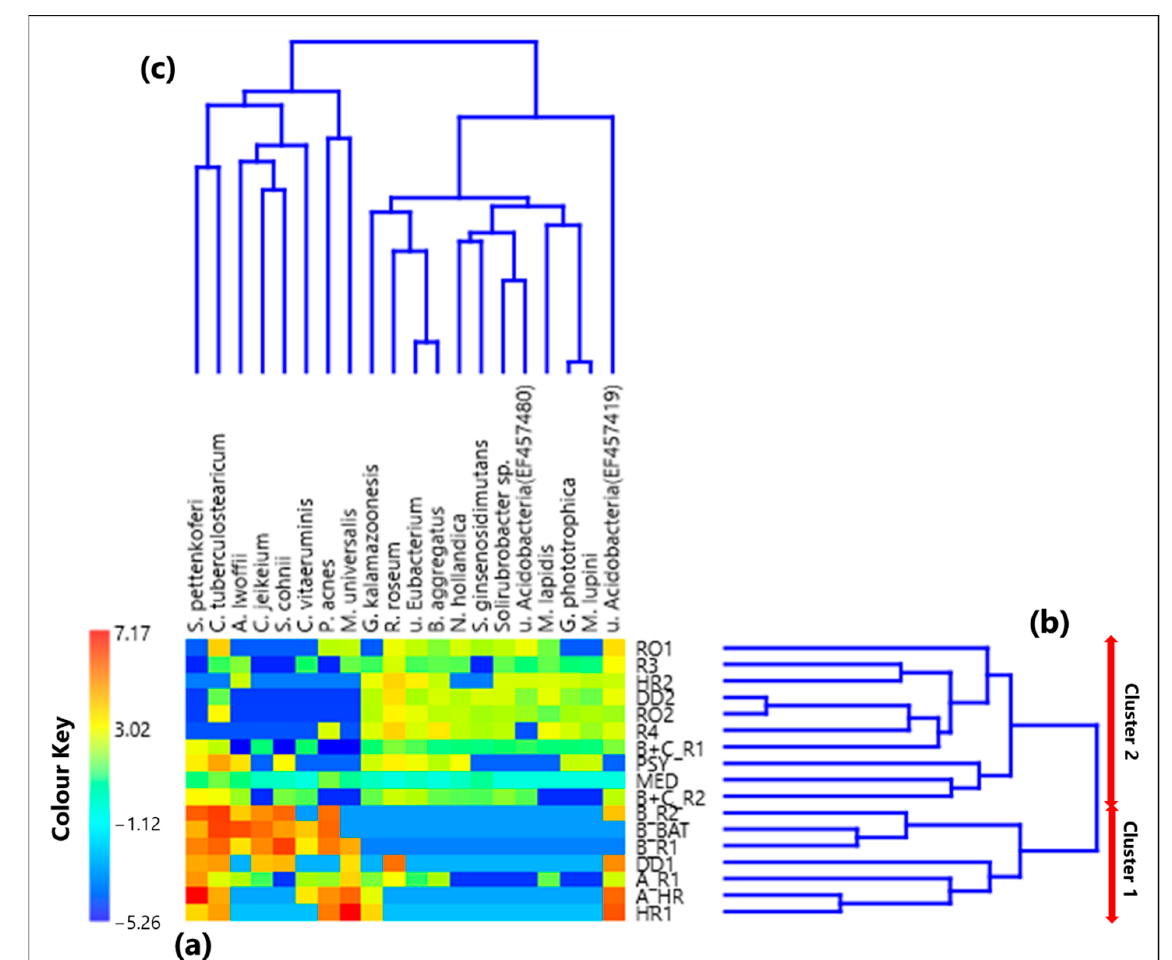
Figure 4. ( a ) Heatmap based on the centered log-ratio (CLR) transformed values of the 20 selected bacterial species reads; ( b , c ) show the Aitchison distance-based dendrograms highlighting the relatedness between different samples and species, respectively. The two main sample clusters defined by the corresponding dendrogram are also indicated in ( b ). Legend: S. ( Staphylococcus ) pettenkoferi , C. ( Corynebacterium ) tuberculostearicum , A. ( Acinetobacter ) lwoffii , C. ( Corynebacterium ) jeikeium , S. ( Staphylococcus ) cohnii , C. ( Corynebacterium ) vitaeruminis , P. ( Propionibacterium ) acnes , M. ( Methylover- satilis ) universalis , G. ( Gemmatirosa ) kalamazoonesis , R. ( Rubellimicrobium ) roseum , u. ( uncultured ) Eu- bacterium , B. ( Blastococcus ) aggregatus , N. ( Nitrolancea ) hollandica , S. ( Solirubrobacter ) ginsenosidimutans , u. ( uncultured ) Acidobacteria (EF457480), M. ( Modestobacter ) lapidis , G. ( Gemmatimonas ) phototrophica , M. ( Microvirga ) lupini , and u. ( uncultured ) Acidobacteria